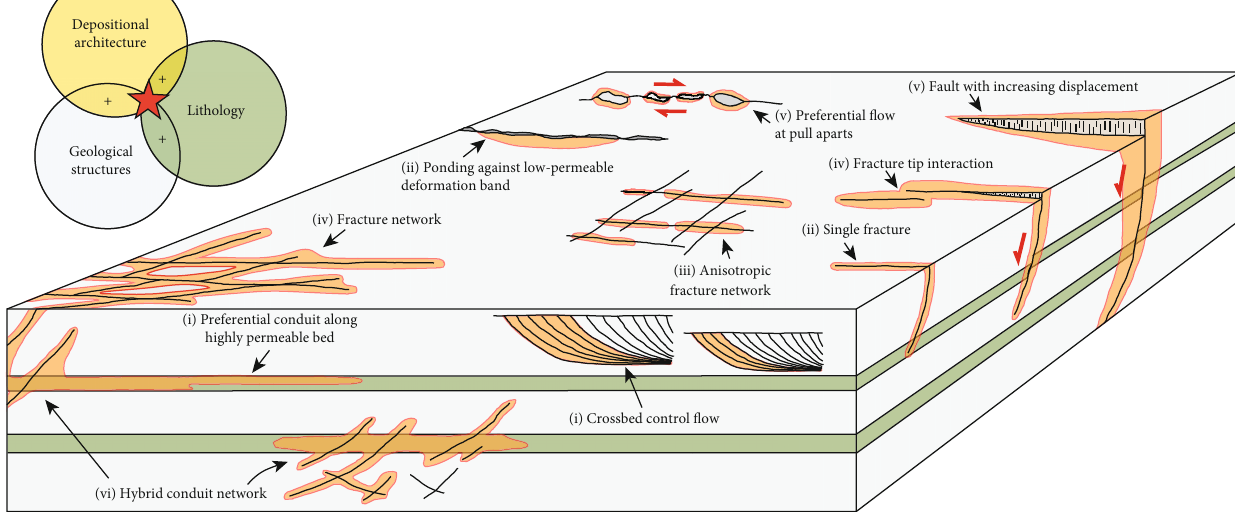
Figure 13: Schematic illustration of the examples of controls on fl uid fl ow in sedimentary rocks presented herein, using iron oxide precipitates (orange) as indicator of palaeo fl uid fl ow. The fl uid fl ow controls are divided into six groups based upon the main control: (i) host rock properties and depositional architecture, as shown in Figure 3; (ii) geological structures as conduits or barriers, as shown in Figures 4, 5 and 6; (iii) anisotropy in fracture populations, as shown in Figure 7; (iv) geometry and connectivity, as shown in Figure 8; (v) kinematics and interaction, as shown in Figures 9 and 11; (vi) hybrid depositional-structural conduit networks, as shown in Figure 12. All of these controls may also interact with each other, as illustrated in the top left